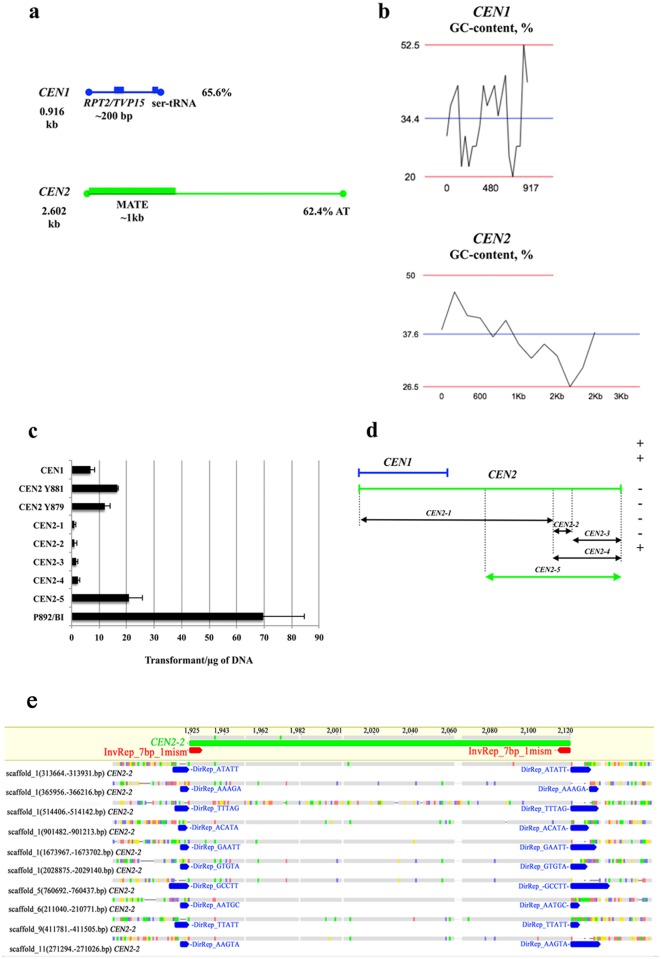
The analysis of CEN1 and CEN2 properties.(a) The CEN1 locus has 65.6% AT content and carries the ser-tRNA gene; it carries part of a gene homologous to the RPT2 gene, the TVP15 gene, and the COPI-coated vesicle-protein encoding gene. The CEN2 locus has 62.4% AT content and it carries the gene coding for the MATE efflux family protein. (b) The AT-peaks occur at the intergenic region in CEN1 and within a 3’-region of CEN2. This subfigure was drawn using the DNA/RNA GC Content Calculator (http://www.endmemo.com/bio/gc.php). (c) The transformation efficiency of three plasmid types. (1) The plasmid with CEN1. (2) Two plasmids with CEN2, specifically the Y881 strain possessing the transposon and the Y879 strain lacking the transposon. (3) The deletion plasmids of CEN2, specifically CEN2-1, CEN2-2, CEN2-3, CEN2-4, CEN2-5; the plasmid CEN2-2 has a transposon. The P892/BI plasmid, which carried the URA3 gene and which had been linearized by BamHI (BI), was used as a control. (d) The schematic representation of the CEN1, CEN2 and CEN2 deletion-plasmids. The sequences that promote autonomous replication and stable maintenance are marked with a plus sign (+); the remaining sequences are marked with a minus sign (-). (e) The MITE-like transposon found within the CEN2 fragment (from 1925 to 2120 bp), named CEN2-2, was used as a query in a search through the D. bruxellensis genome (Y879 strain). 10 sequences (and their surroundings) were randomly sampled from the 51 present in the genome (S2 Table) and aligned with CEN2-2 (reference sequence) to present the “structural” parts of the transposon: inverted and direct repeats. The bases identical to the reference sequence are shown in grey. Inverted repeats are 7 bp long and they are at the beginning and end of the transposon; marked with red arrows only on the reference sequence, inverted repeats are present in all sequences in the genome. Direct repeats are marked with blue arrows; they are 5 bp long but have different sequences, and they immediately flank the transposon (in the genome of Y879 strain).